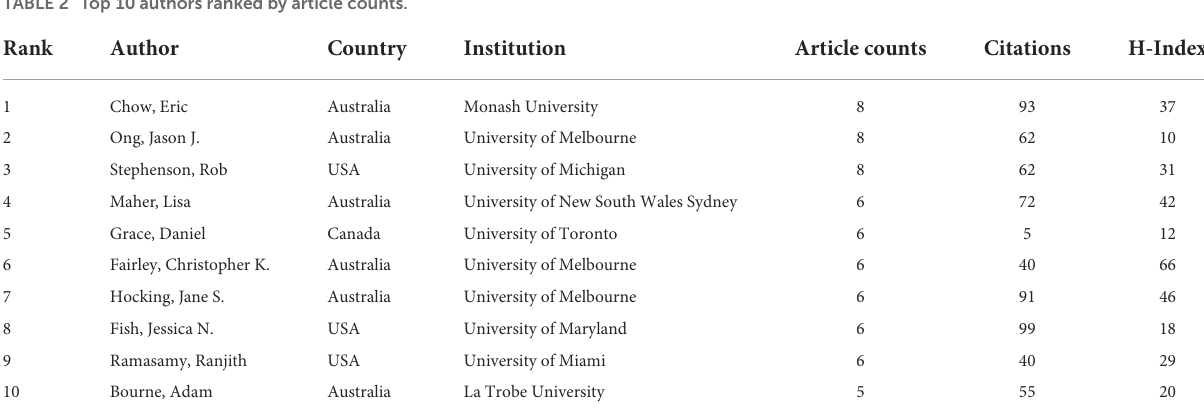
TABLE 2 Top 10 authors ranked by article